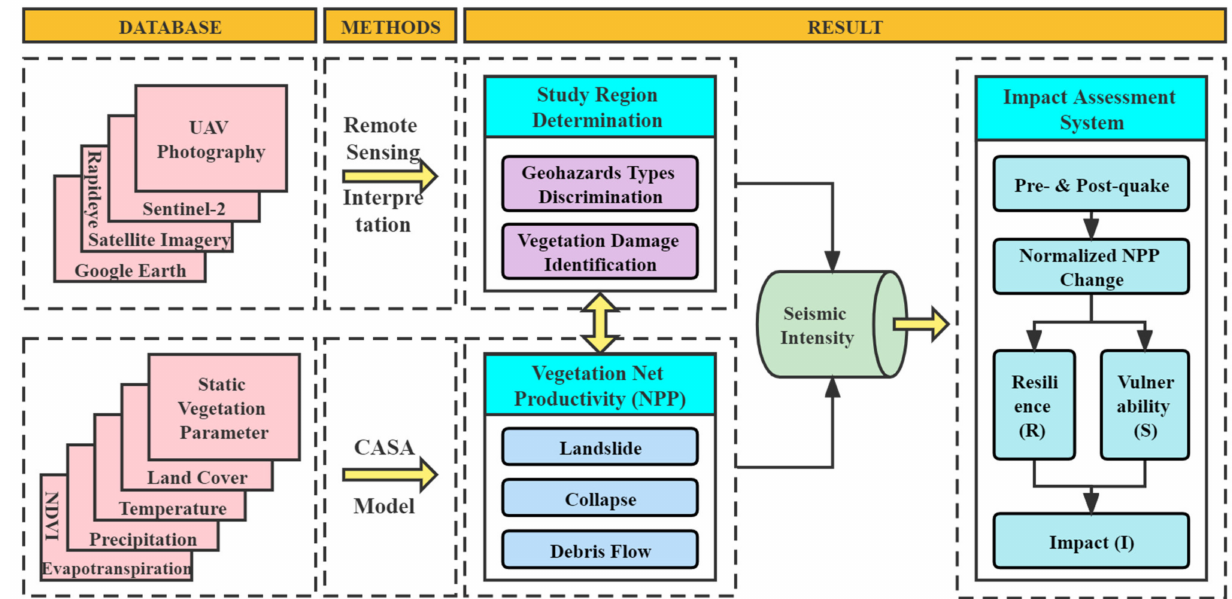
Figure 1. Workflow of the